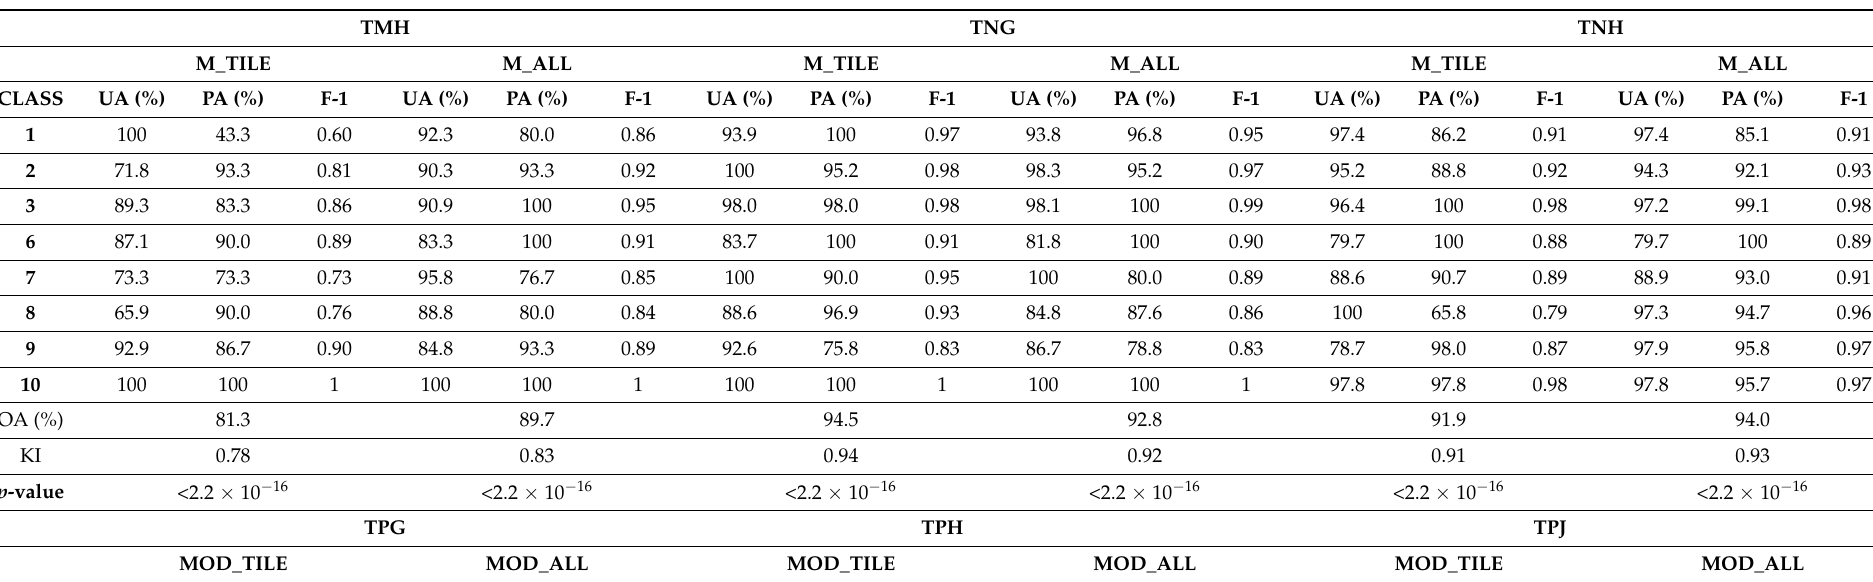
Table 8. Comparison of the accuracy metrics obtained from the cross verification of the two different classifications created following the different model creation strategies for the entire surface area of Galicia. M_TILE: An independent model for each tile. M_ALL: A single model for the entire surface area of Galicia. Metrics presented: Users Accuracy (UA), Producer’s Accuracy (PA) and Overall Accuracy (OA), F-1 score, Kappa Index (KI) and its derived p -value ( p -value). Classes: Eucalyptus spp. (1), Conifers (2), Broadleaves (3), Crops and pastures (6), Shrubs (7), Bare soil (8), Anthropogenic areas (9) and Water